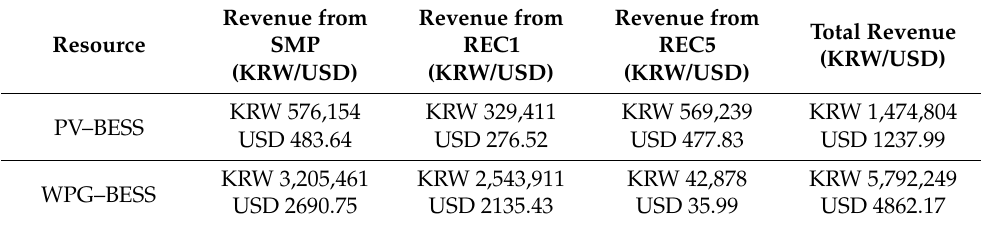
Table 14. Intraday revenue generated with the reliability constraints and